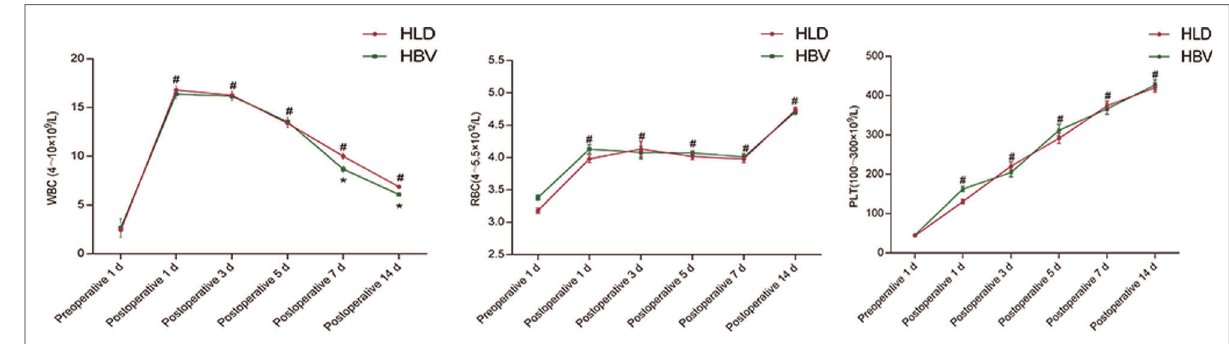
FIGURE 2 Blood routine before and after splenectomy in two groups. # refers to P <0.05 compared with preoperative, * refers to the difference between the two groups at each time point P <0.05, and ** refers to the difference between the two groups at each time point P